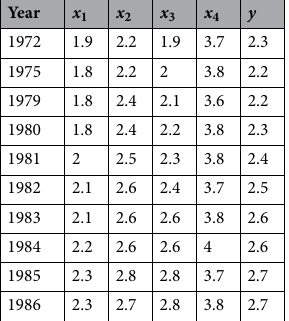
Table 1. 1972–1986 research and development expenditure as a percentage of GNP.